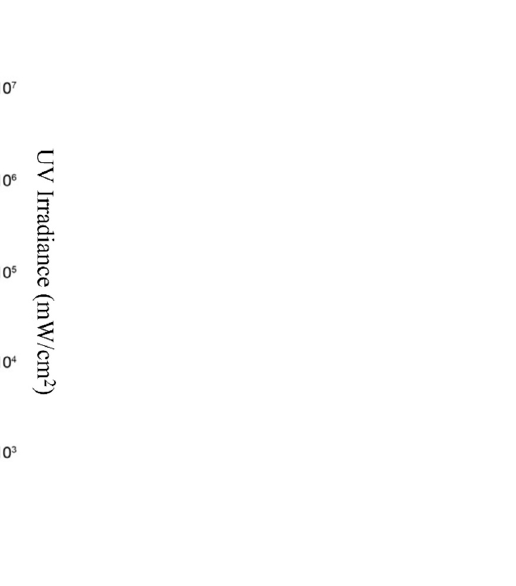
Figure 9. Ray tracing analysis of simulated Al 2 O 3 pastes containing spherical or octahedral particles.